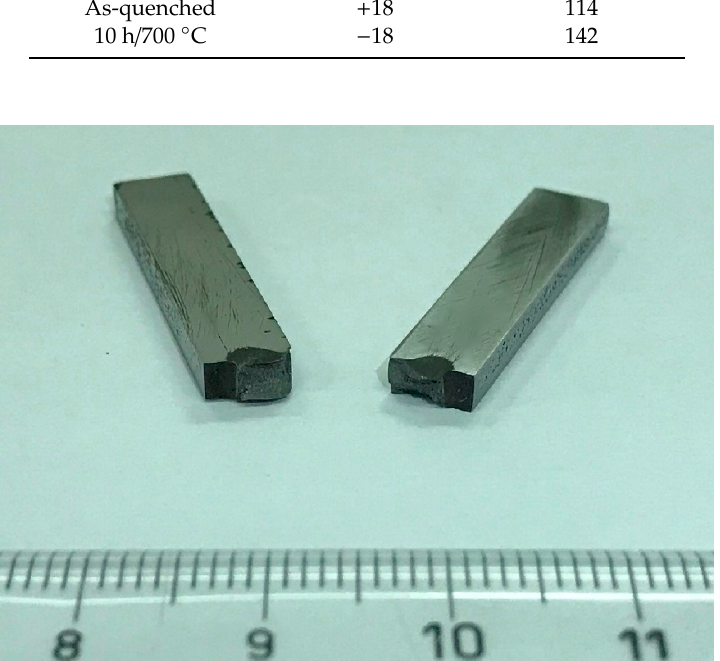
Figure 1. A probe broken in Charpy test (ductile field).